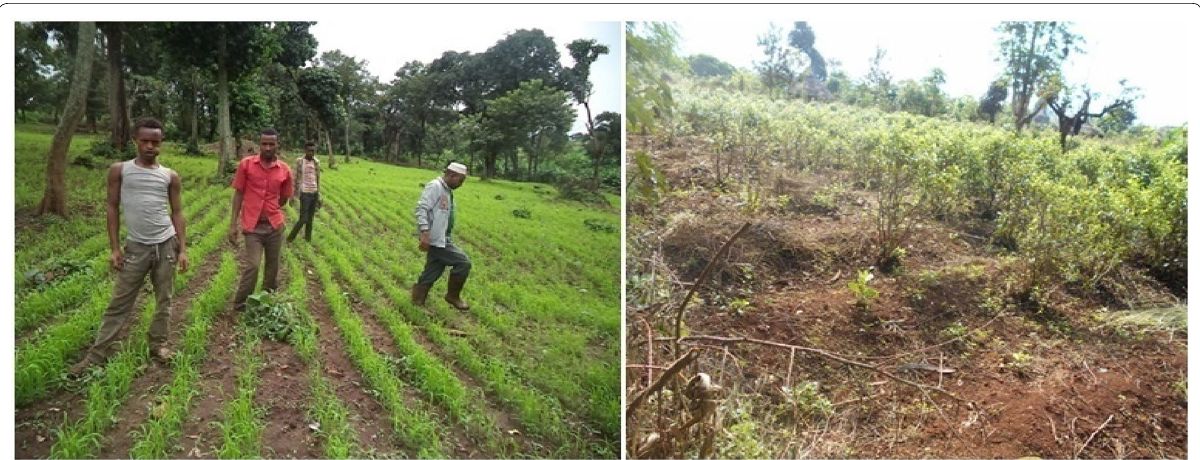
Fig. 6 Farmland expansion (rice cultivation and chat plantation) in Chewaka district, field photo (2018)